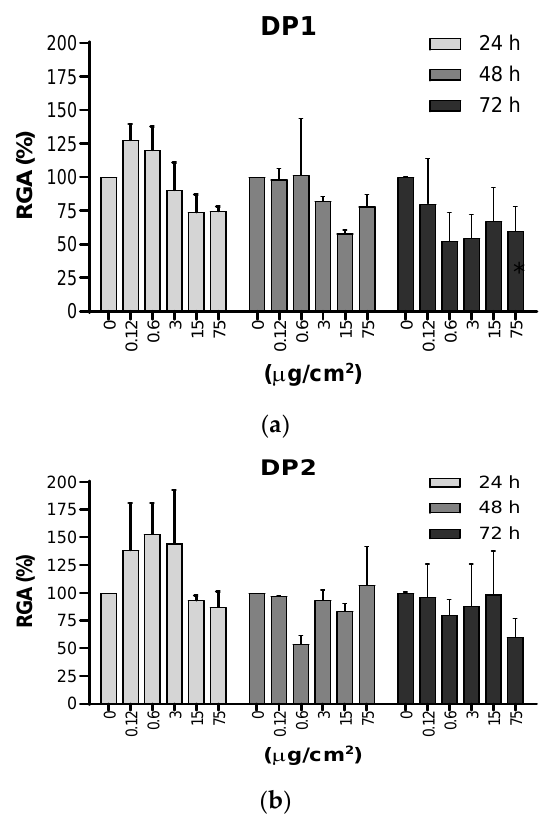
Figure 3. ( a ) and ( b ). Cytotoxic effects measured as the relative growth activity (RGA %) on V79-4 cells exposed to TiO 2 NPs prepared using the two dispersion procedures (DP1 and DP2). Cells were treated with 5 concentrations (µg/cm 2 ) of TiO 2 NPs for 24, 48 and 72 h, and the cell numbers were counted at each time point immediately, following trypan blue staining. There were no statistical significances between exposed and unexposed cultures. Cytotoxicity of MMS was not been observed (RGA = 70%). Data are expressed as the means ± SEM of two parallel experiments, according to the used procedures.